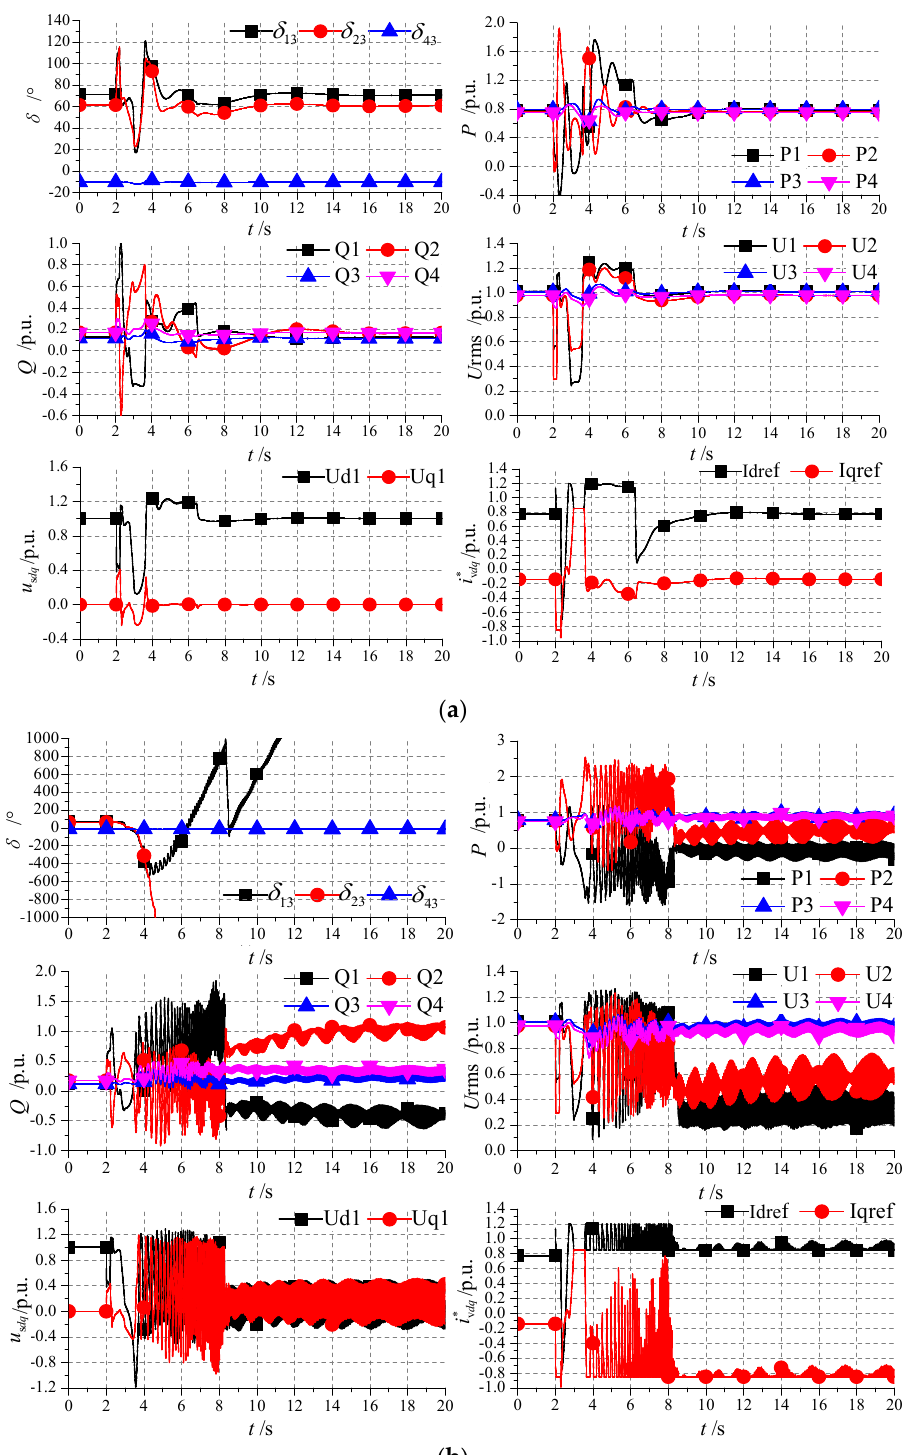
Figure 11. The critical clearing time for three-phase short-circuit fault on B3: ( a ) The fault duration of 0.198 s; ( b ) The fault duration of 0.199 s.